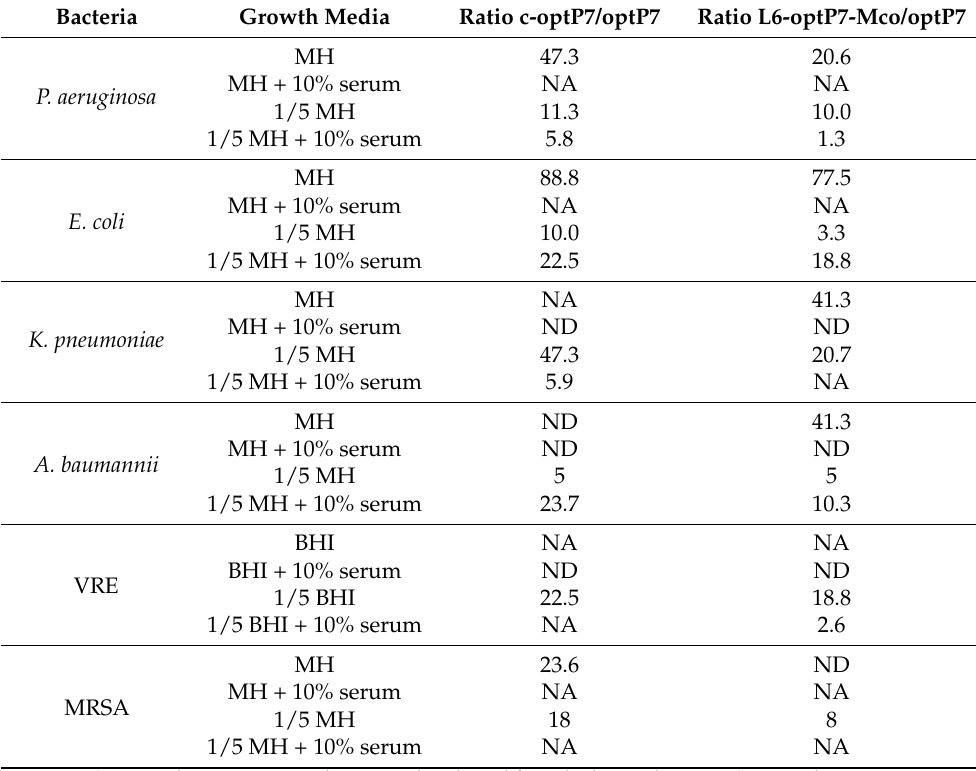
Table 3. Ratio of MICs of cyclized peptide versions over MICs of the linear